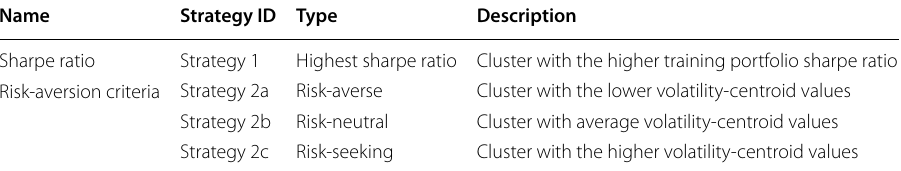
Table 2 Strategies for prototype selection